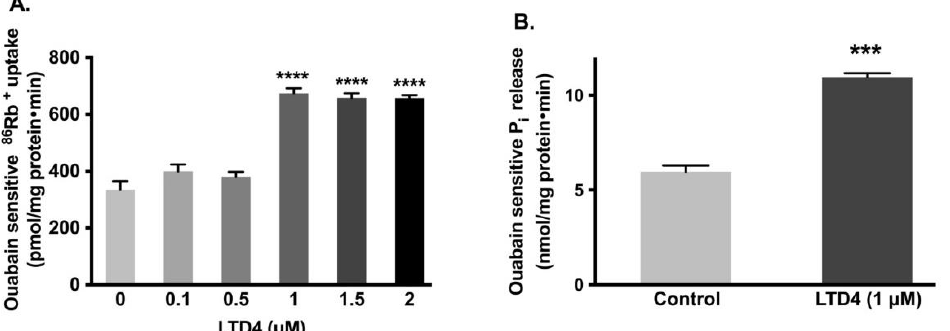
Figure 1. Effect of LTD4 (leukotriene D4) exposure for 24 h on Na-K-ATPase activity in IEC-18 cells. ( A ) Measurement of Na-K-ATPase activity by 86 Rb + uptake ( n = 6, Dunnett’s multiple comparison test). ( B ) Measurement of Na-K-ATPase activity by P i release in plasma membrane ( n = 4, unpaired t -test). Values are represented as means ± SEM. *** p < 0.001, **** p < 0.0001 vs. 0 µ M or